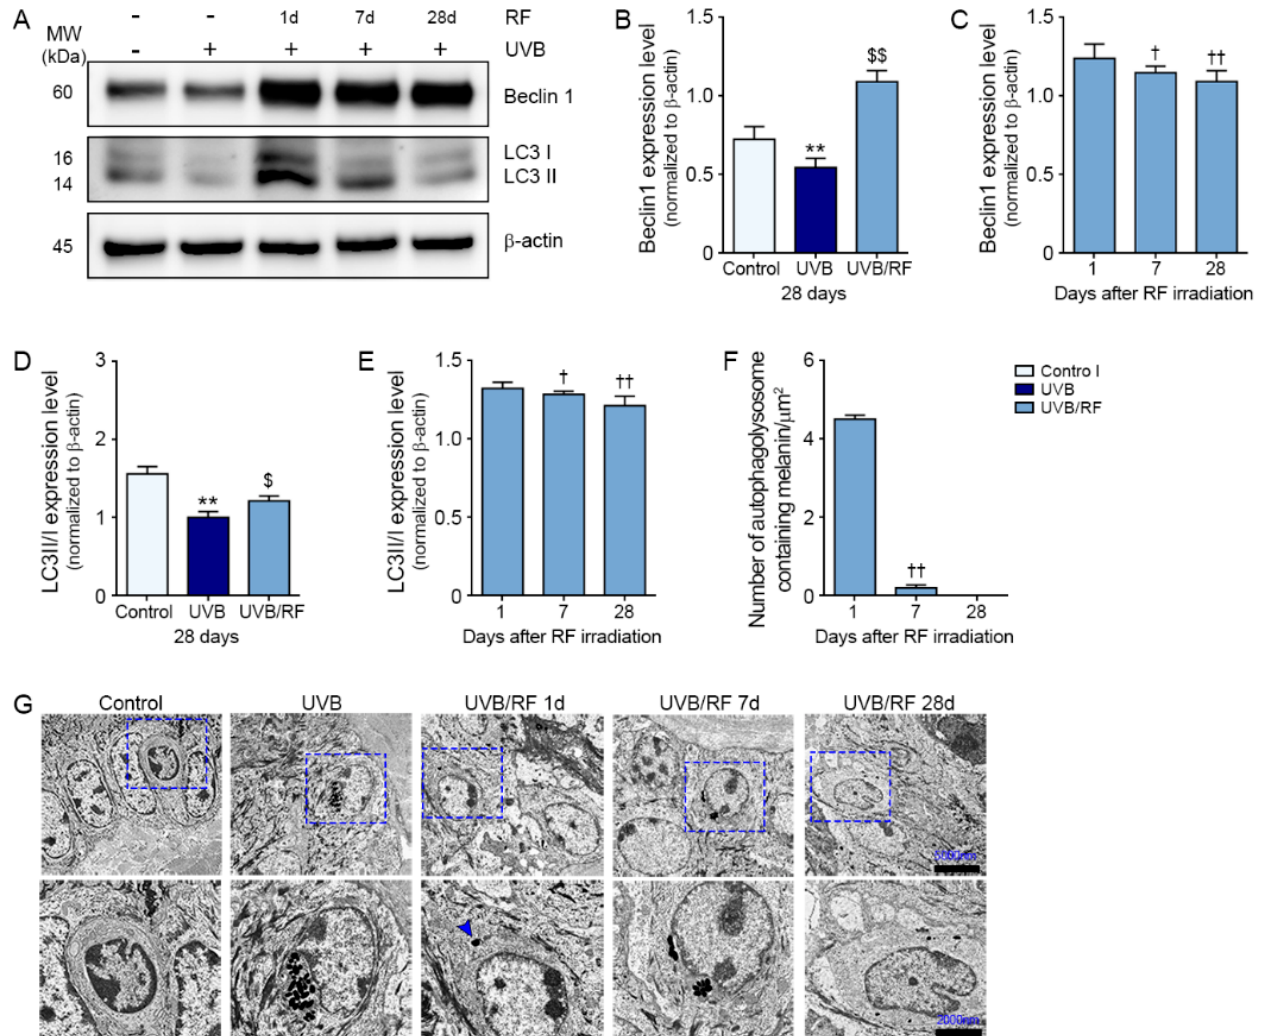
Figure 3. Activation of autophagosomes by RF irradiation in the UV-B-exposed animal model. ( A ) The expression levels of autophagy-related factors in skin tissue were assessed by Western blot; ( B – E ) Quantitative graphs of representative Western blot images. The protein expression levels were normalized to β -actin; ( F ) Quantitative graphs of representative TEM images; ( G ) Changes in autophagosome (arrows) numbers with time after RF irradiation were observed under TEM. Data are presented as mean ± SD. **, p < 0.01, vs. control (HEKn) or control 28 days (Skin); $, p < 0.05; $$, p < 0.01, vs. UV-B (HEKn) or UV-B 28 days (Skin); †, p < 0.05; ††, p < 0.01, vs. 1 day after RF irradiation (Mann–Whitney U test). LC3, microtubule-associated protein 1A/1B-light chain 3; RF, radiofrequency; TEM, transmission electron microscopy; UV-B, ultraviolet-B; UV-B/RF, UV-B plus RF.